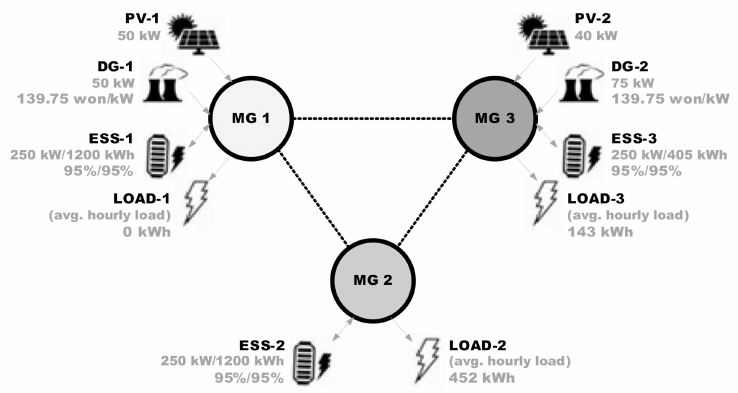
Figure 4. The configuration of hypothetical multi-microgrid test bed for case study.